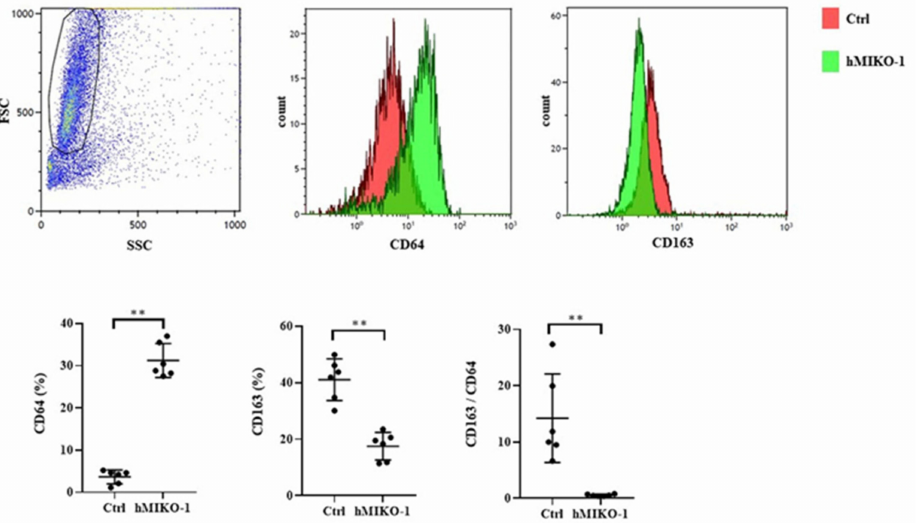
Figure 3. Cell surface antigens of murine macrophages. Expression of CD64 and CD163 and the CD163/CD64 ratio. hMIKO-1: hMIKO-1 co-culture group. Ctrl: Control group in which hMIKO-1 was not added. Data are shown as mean ± SD (N = 6 per group). ** p < 0.01, significant difference between the linked groups. NS: not significant.